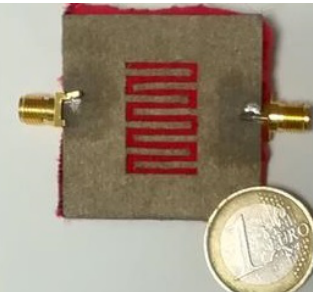
Figure 8. Picture of the back of the hairpin resonator. c (cid:13) [2019] IEEE. Reprinted, with permission, from